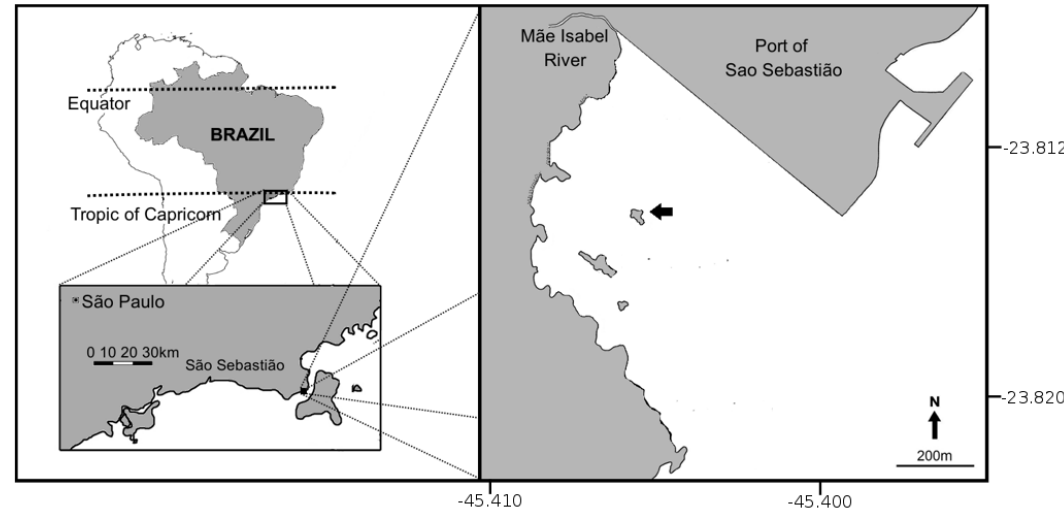
Figure 1. Map indicating the location of the Araçá Bay. The arrow indicates the sampling site.